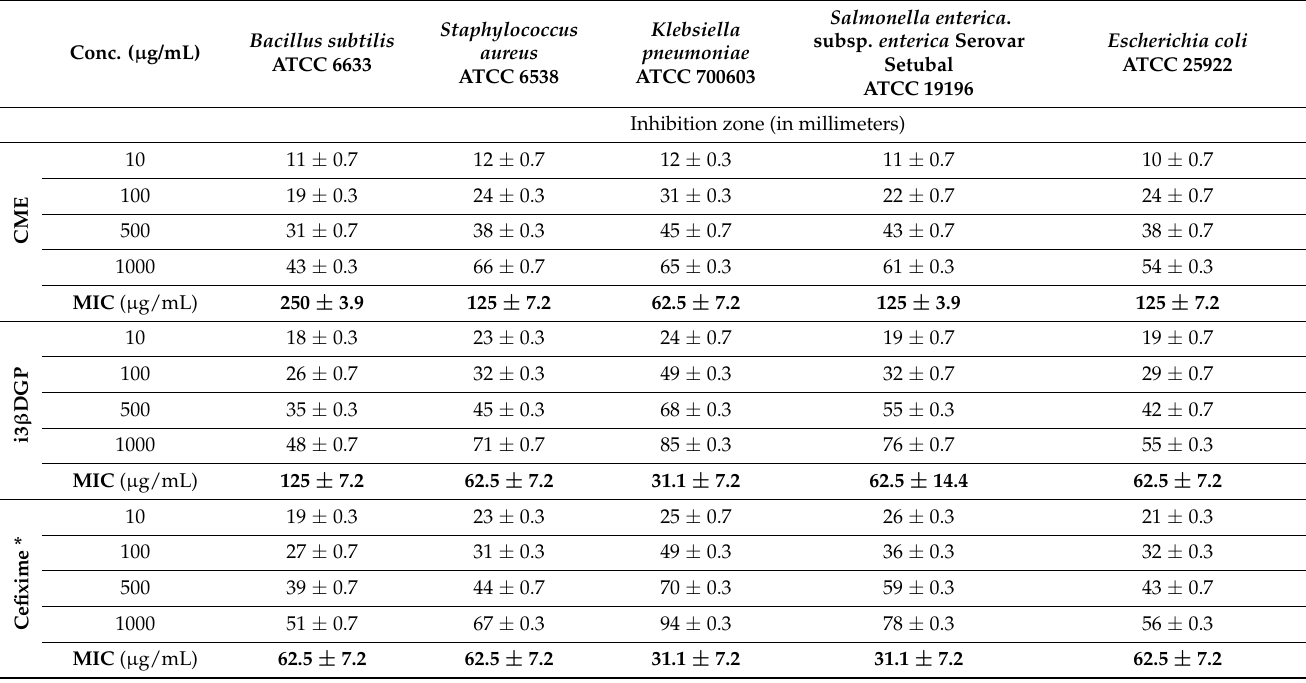
Table 2. Comparing the antibacterial potential of crude methanolic extract of Dryopteris ramosa , iriflophenone-3-C- β -D glucopyranoside and well-known antibiotic (Cefixime) against five bacterial strains.